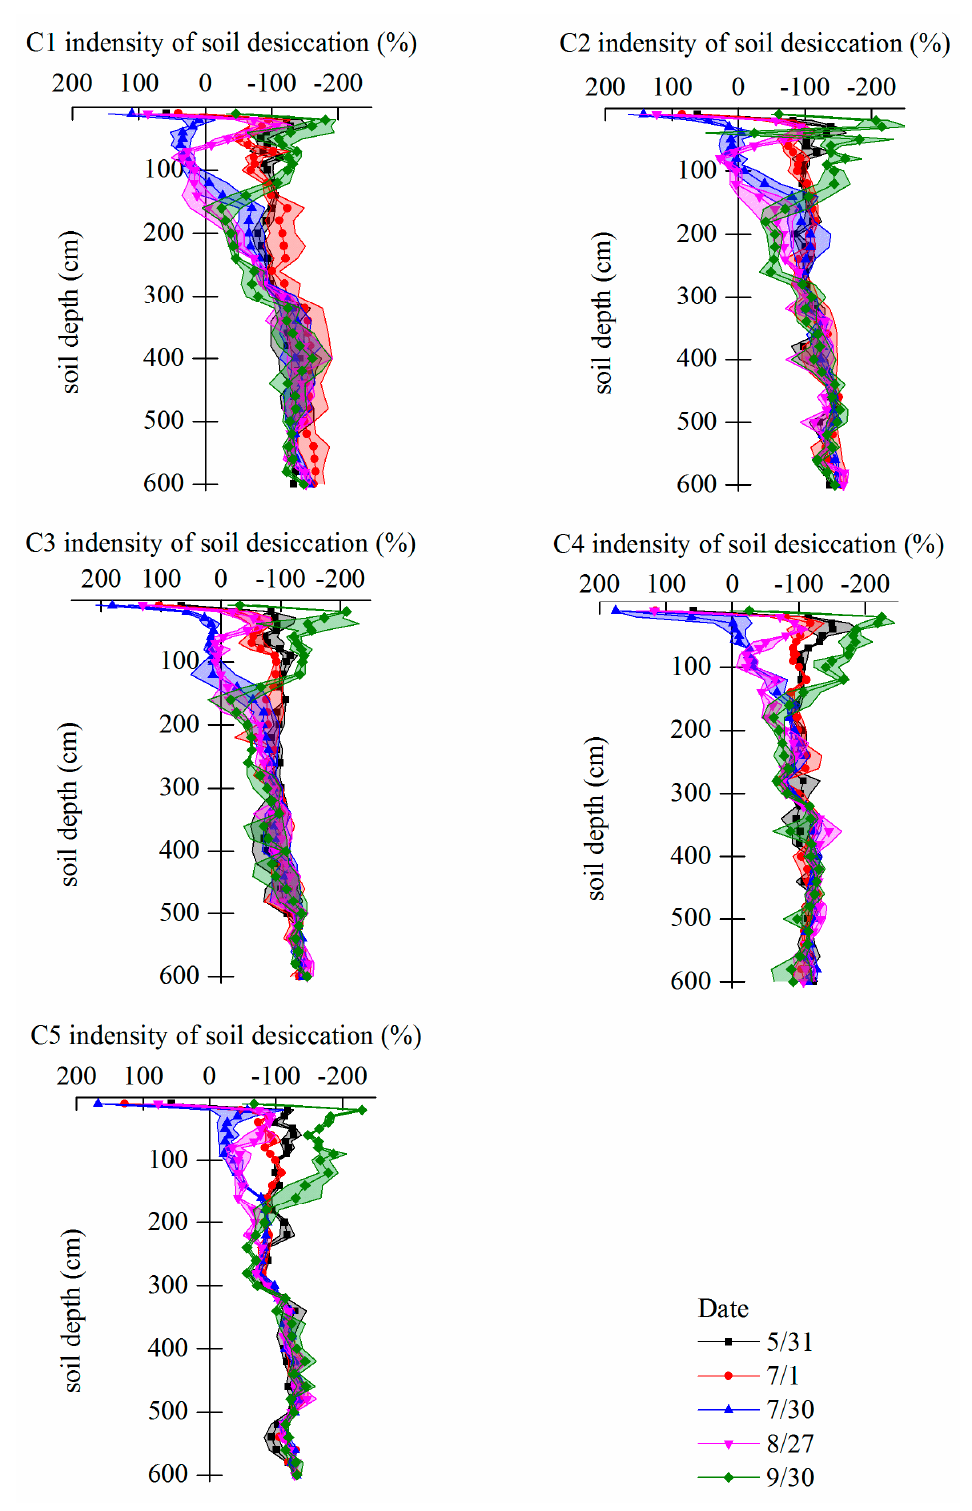
Figure 9. Intensity of soil desiccation (%) at each monitoring site in the cropland.